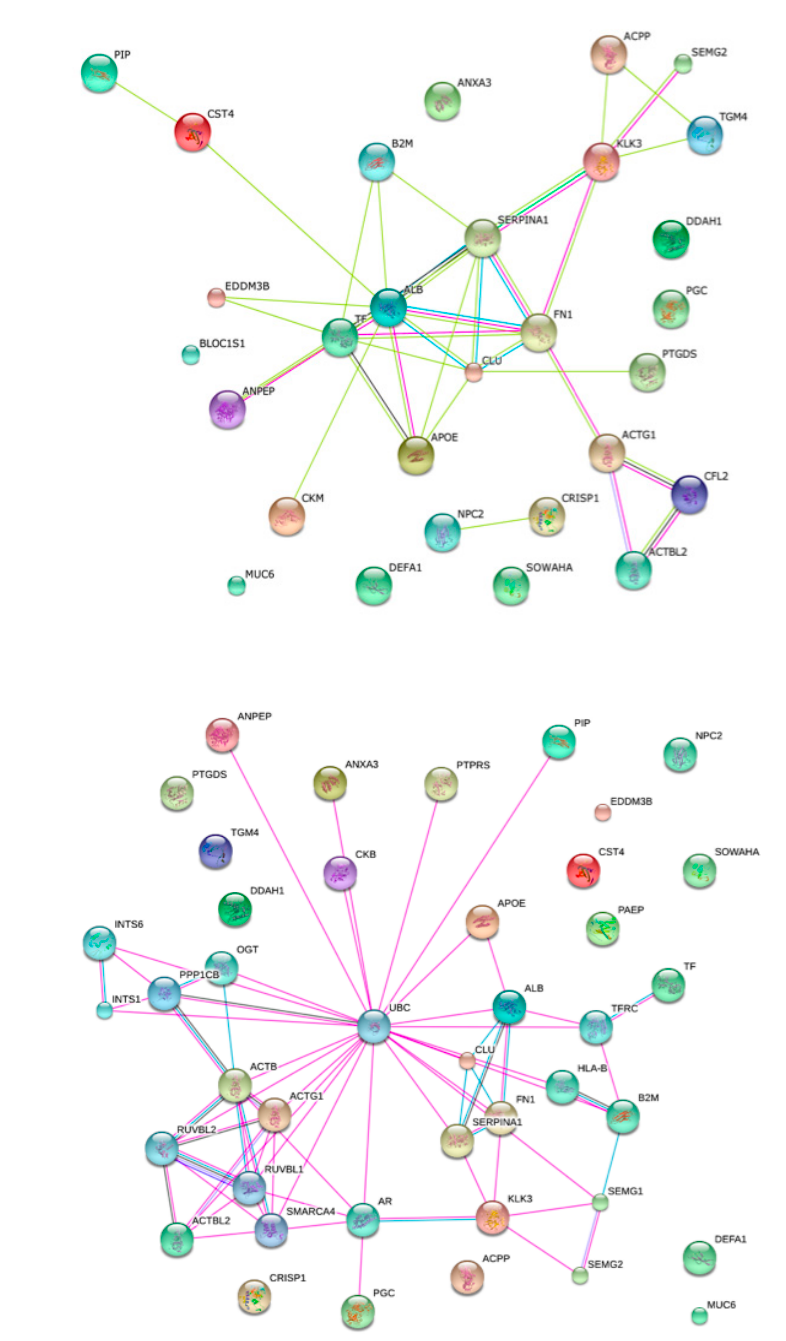
Figure 3. Search Tool for the Retrieval of Interacting Genes / Proteins (STRING) Network nodes among identified proteins ( a ) and in a second shell ( b